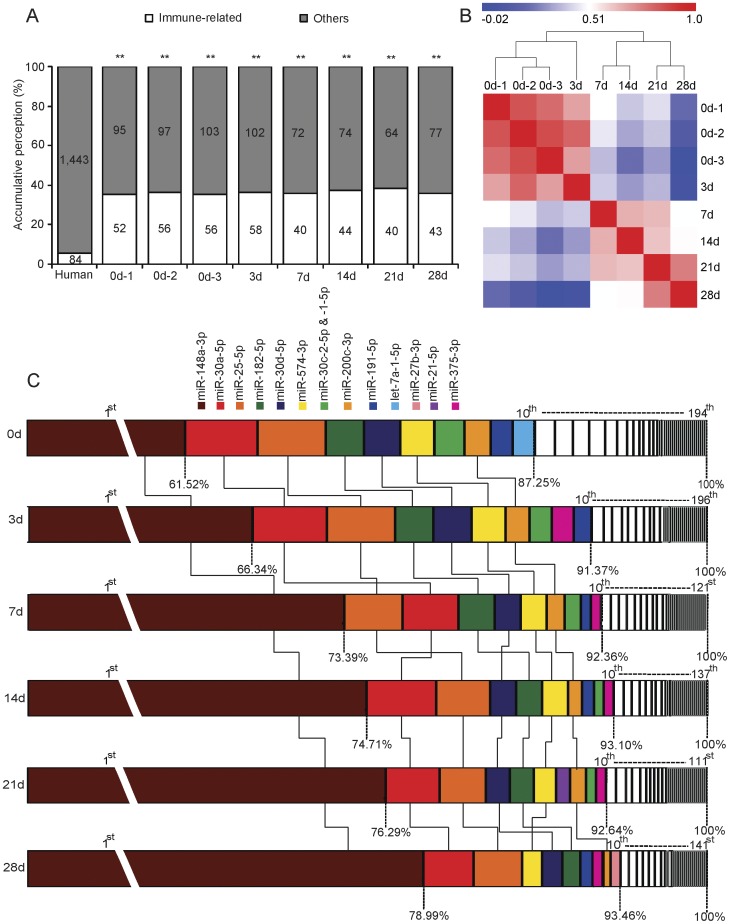
Lactation-related miRNA expression profiles.(A) Distribution of lactation-related pre-miRNAs. Out of 1,527 pre-miRNAs deposited in miRBase 18.0, 84 (5.50%) pre-miRNAs have been designated as immunopathology-related pre-miRNAs, based on annotation in the Pathway Central database (SABiosciences, MD, USA). These immune-related pre-miRNAs are enriched in each milk exosomal miRNA library. χ
2 test (**p<10−16): Numbers of immunopathology-related miRNAs and others detected in milk exosomes compared with the total entries in miRBase 18.0. The three biological replicates at 0 days are denoted by 0d-1, -2 and -3, respectively. (B) Hierarchical clustering and heat map matrix of pairwise Spearman correlations of the counts of 234 unique miRNAs between eight exosomal miRNA libraries. (C) Top 10 unique miRNAs with the highest expression levels in milk exosomal miRNA libraries. Plot of the unique miRNAs versus their % in total counts of all unique miRNAs for each library. The dashed vertical lines represent the accumulative % of the top 10 unique miRNAs in total counts of all unique miRNAs. Seven miRNAs that are present in the top 10 miRNAs in all six libraries are connected by lines.